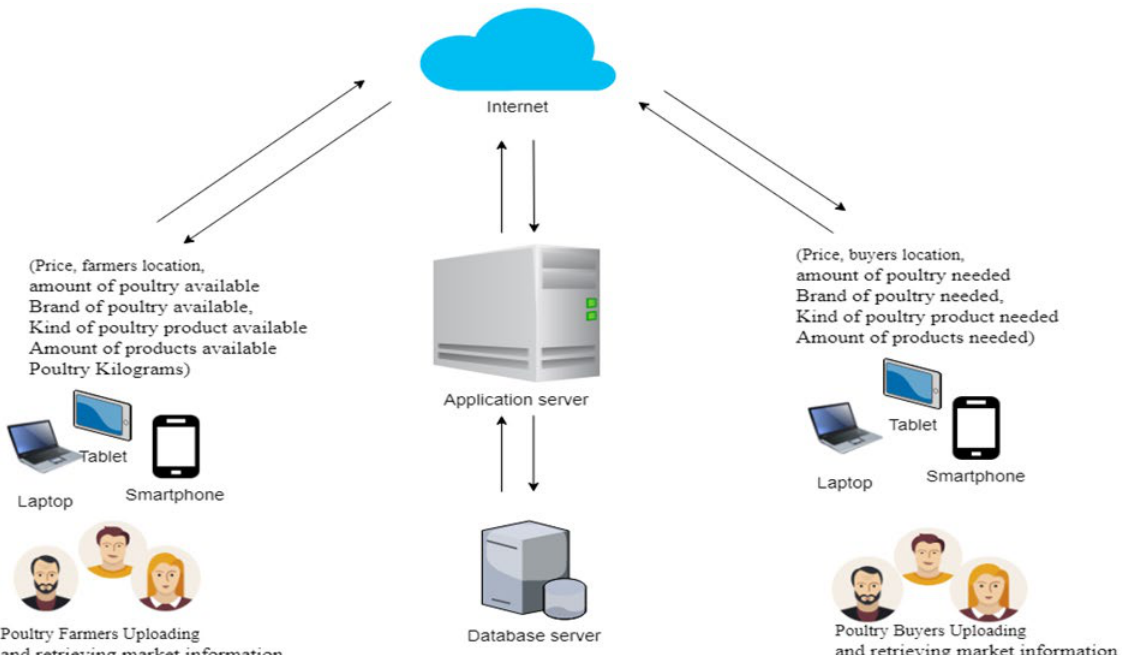
Figure 7. Framework of the proposed solution,